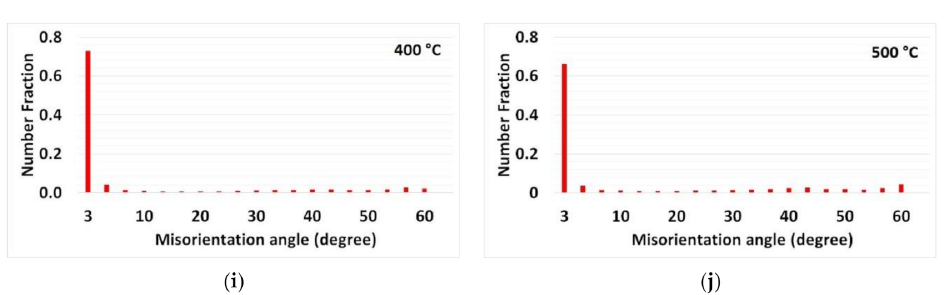
Figure 8. Grain size distribution data ( a ) WPH ( b ) 200 ◦ C ( c ) 300 ◦ C ( d ) 400 ◦ C ( e ) 500 ◦ C and grain boundary misorientation data ( f ) WPH ( g ) 200 ◦ C ( h ) 300 ◦ C ( i ) 400 ◦ C ( j ) 500 ◦ C.